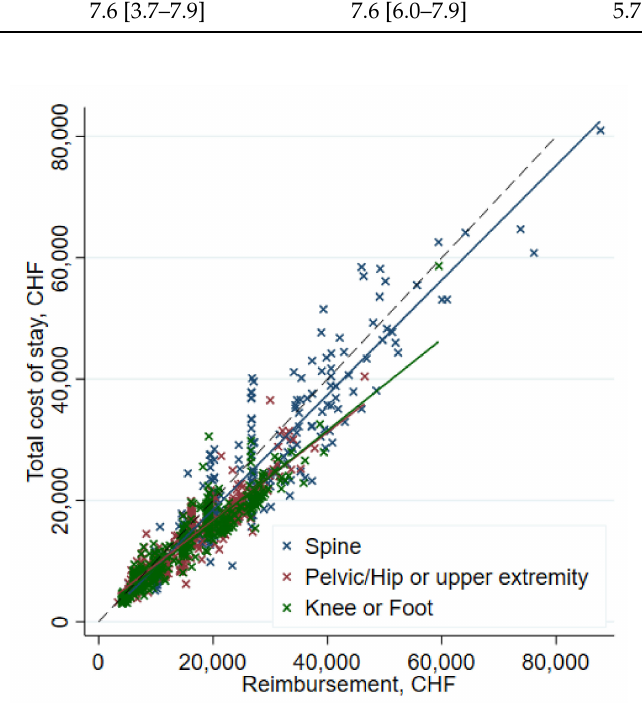
Figure 12. Costs and reimbursement by type of surgery. Dashed line indicates net financial zero. Dots to the right of the dashed line indicate a positive net financial result. Lines in color are regression lines by surgery